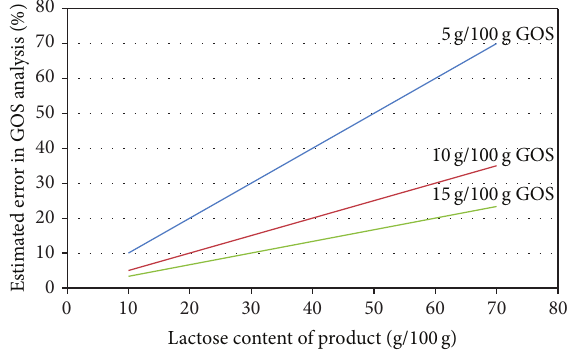
Figure 3: Estimated error on GOS determination by AOAC 2001.03 depending on lactose and GOS concentration assuming a 5% error on the lactose